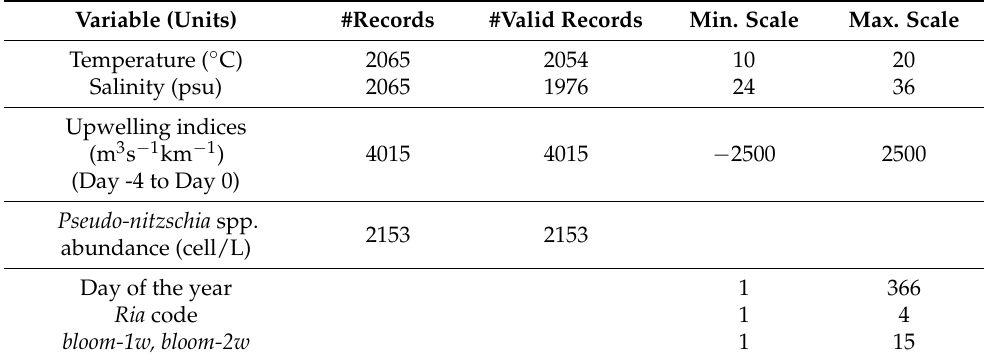
Table 1. List of variables included in the models, indicating the number of records and valid records, as well as the minimum and maximum values used to scale each variable.